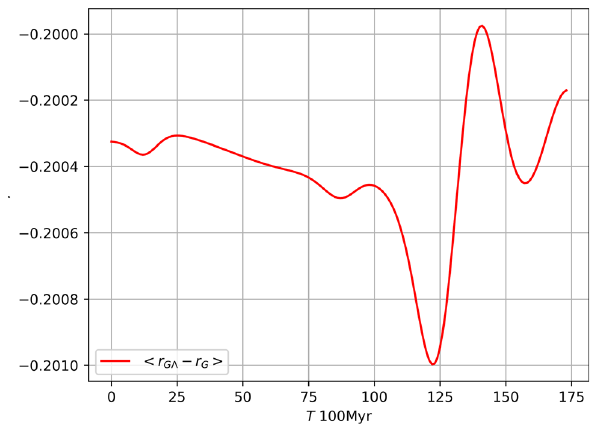
Fig. 5 The same as in Fig. 3 but for R = 10